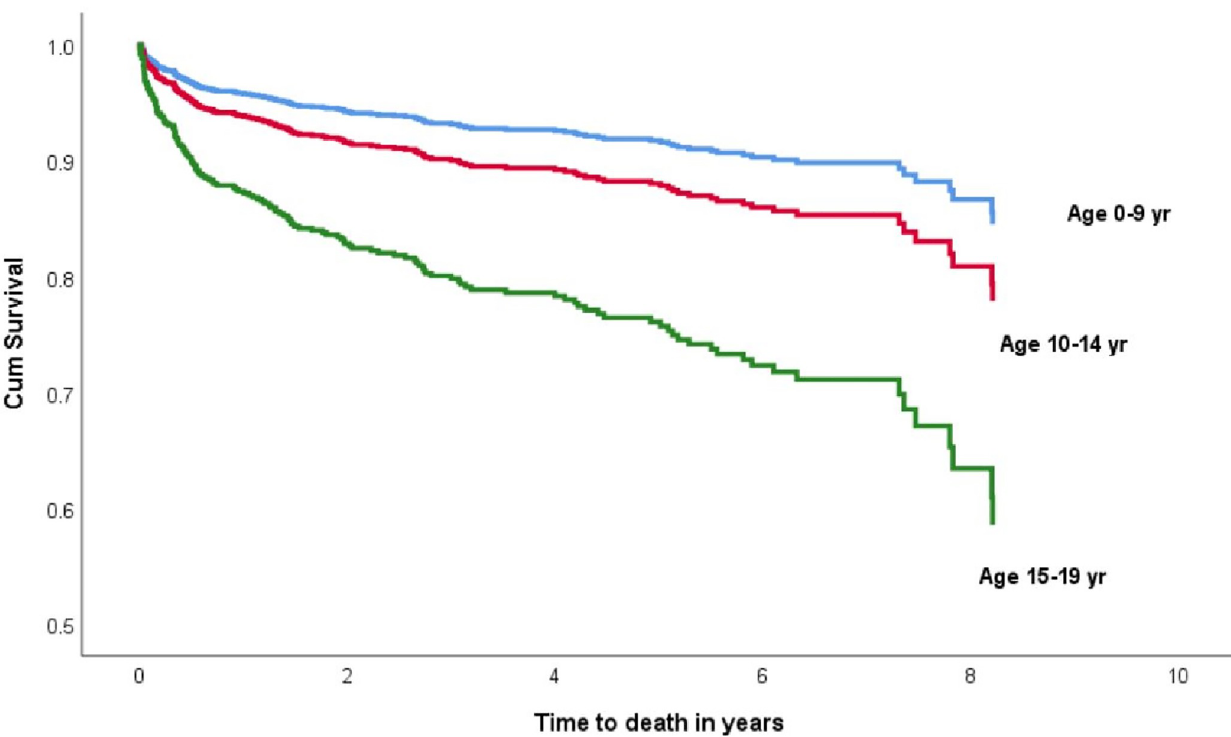
Fig 3. Time-to-death by age category after adjusting for potential